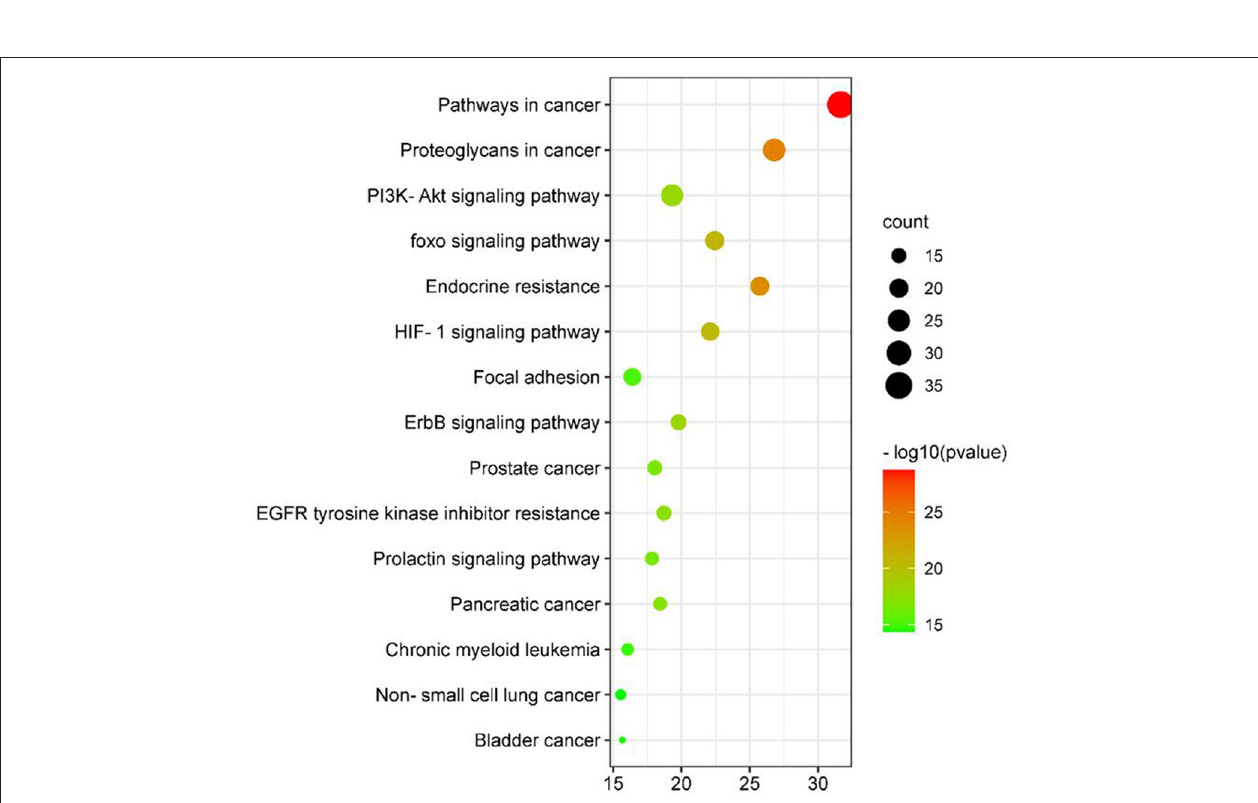
FIGURE 8 | Bubble chart of KEGG pathway enrichment analysis of antioxidant targets in AS.